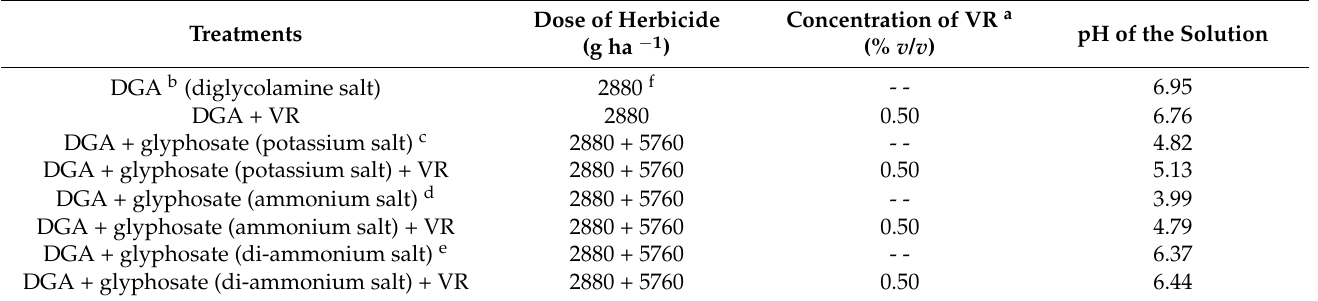
Table 3. Treatments applied to trays with